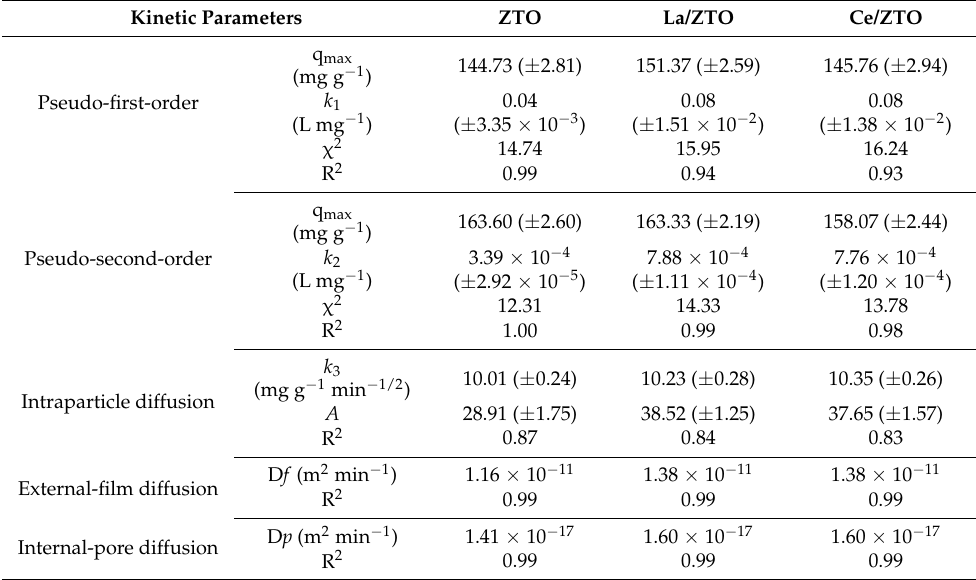
Table 3. Kinetic parameters for cyanide sorption on